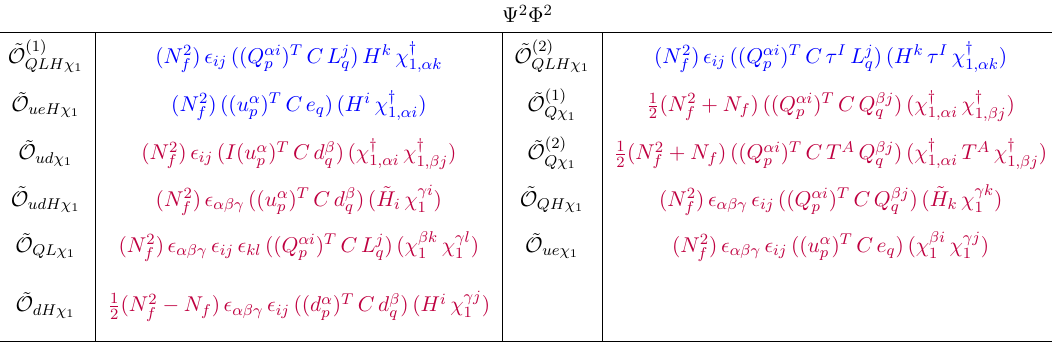
Table 19 . SM extended by Lepto-Quark ( χ 1 ): additional operators of dimension 5. Here i, j, k, l and α, β, γ are the SU(2) and SU(3) indices respectively. T A and τ I are SU(3) and SU(2) generators respectively. A = 1 , 2 , · · · , 8 and I = 1 , 2 , 3 . p, q = 1 , 2 , · · · , N f are the flavour indices. Operators in red violate lepton and baryon